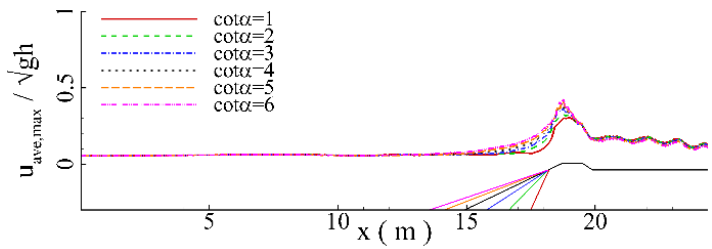
Figure 44. Space distributions of the maximum depth-averaged velocity.